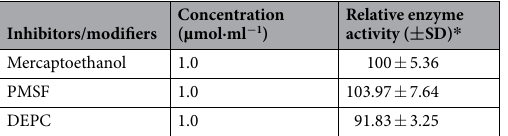
Table 1. Effects of amino acid, protease inhibitor or protease modifier on the activity of purified Est3385